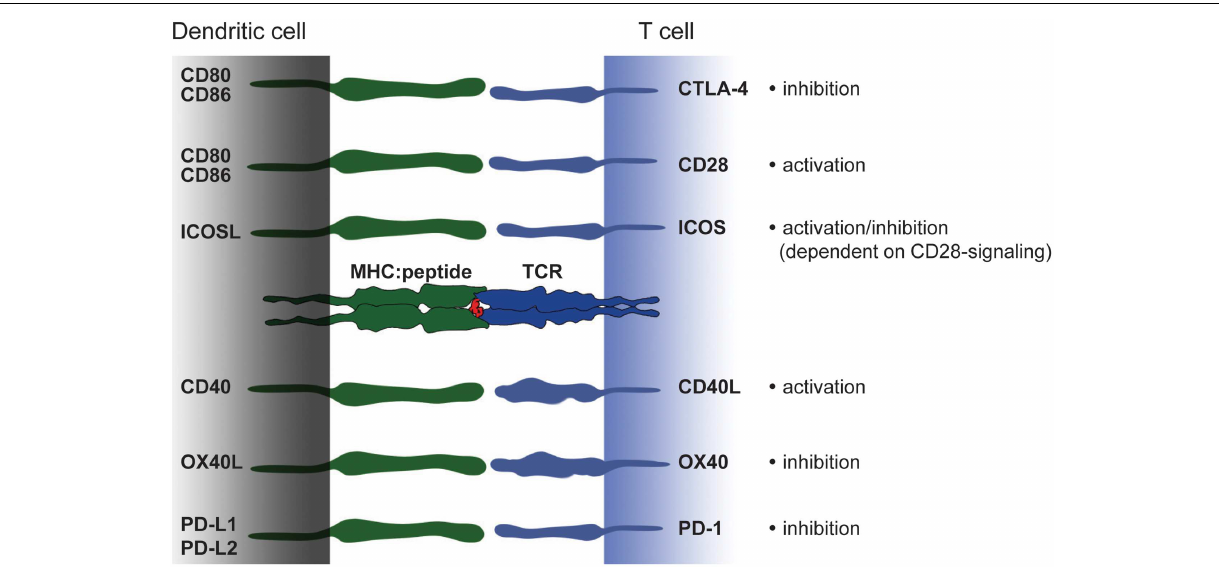
FIGURE 3 | Costimulatory molecules and their ligands – a brief overview. Modulation ofT cell activation is mediated by an interplay of different costimulatory molecules expressed on DC that have either immunogenic or tolerogenic function.The picture shows an overview of members from the B7 andTNF-receptor family expressed on DC and their binding partners onT cells.